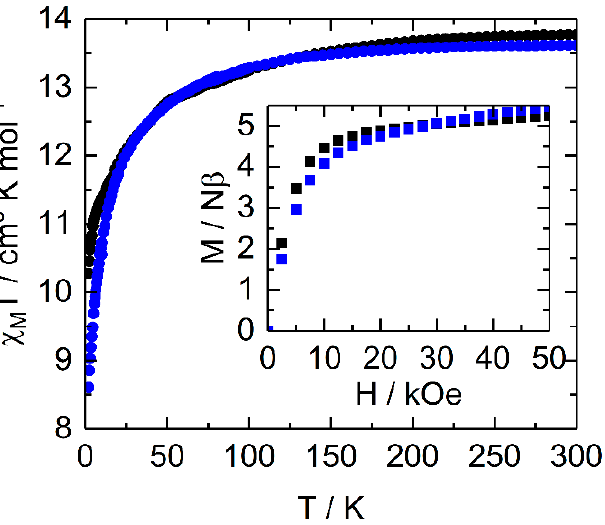
Figure 3. Temperature dependence of χ M T for 1 (blue) and 2 (black) between 2 and 300 K. In inset, the field variations of the magnetization at 2 K for 1 (blue) and 2 (black) between 0 and 50 kOe. The measured magnetizations at 50 kOe are 5.46 μ B for 1 and 5.24 μ B for 2 far from the expected saturated value of 10 μ B , due to the magnetic anisotropy of the systems (inset